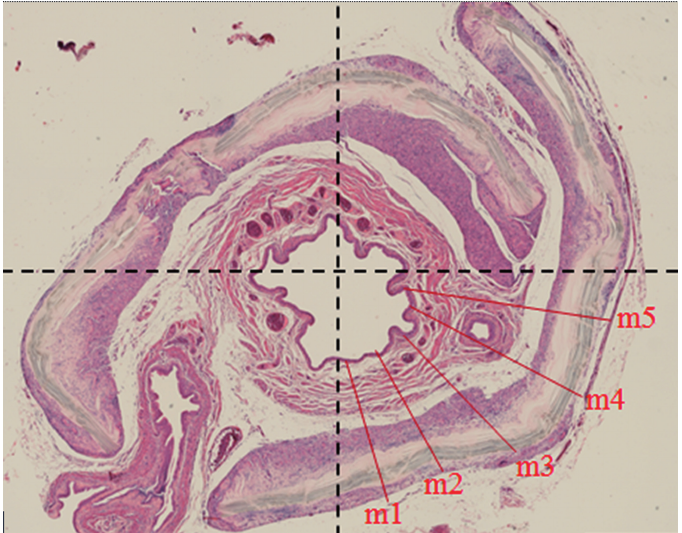
Figure 1 - The urethral wall was measured in the lamina propria to the outer limit of the muscular layer according with the image. The area was divided in four quadrants to obtain the average of 20 measurements for each animal, making up 5 measurements in each of